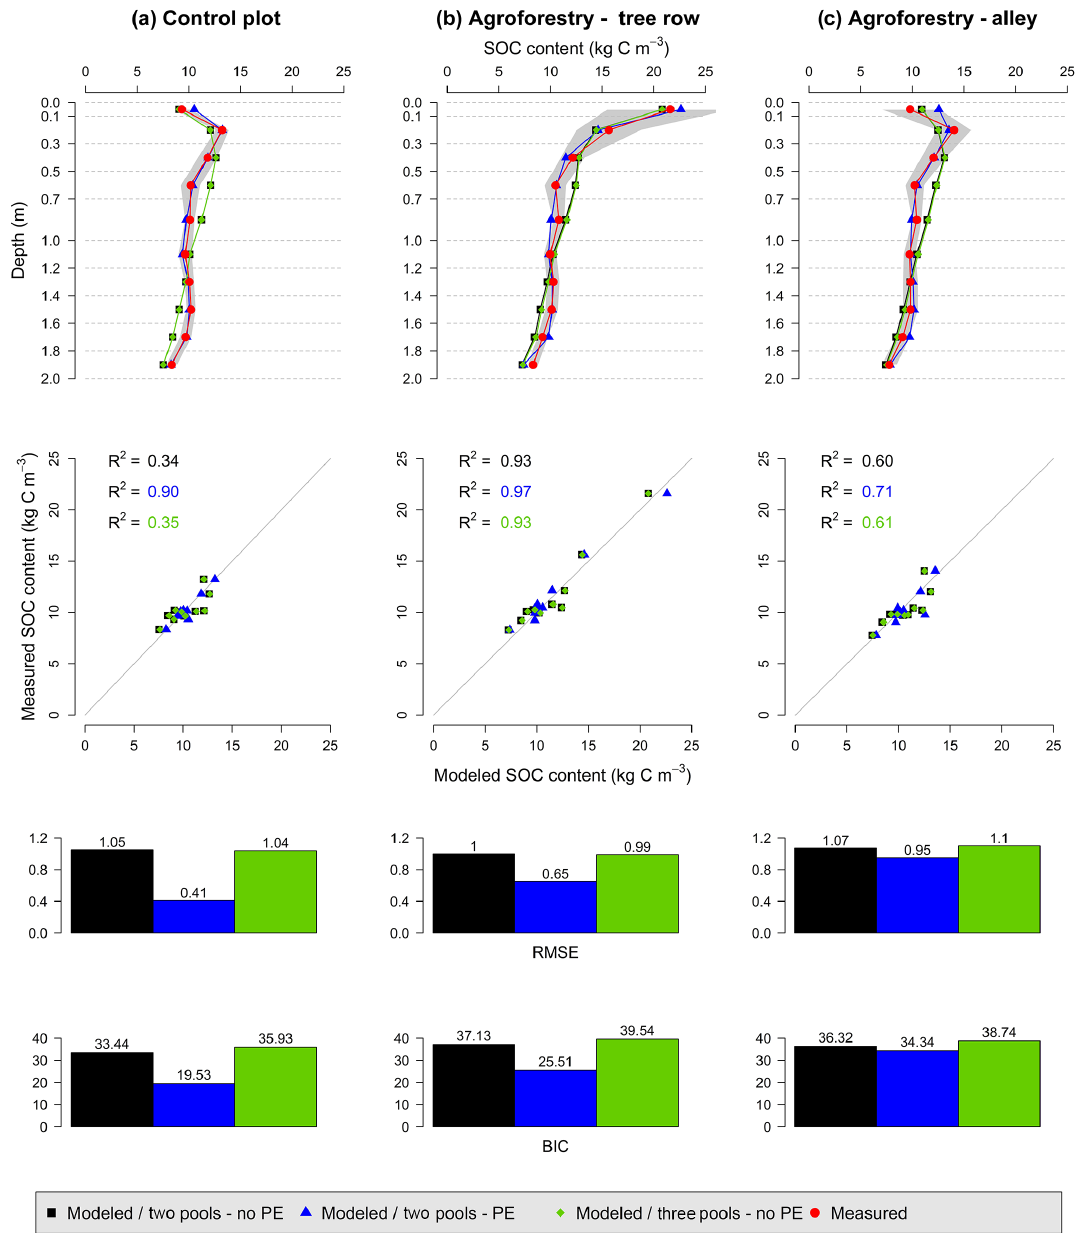
Figure 5. Measured and modeled soil organic carbon contents (kgCm − 3 ) in an agricultural control plot and in an 18-year-old silvoarable system with a two-pool model without the priming effect (no PE), with a two-pool model with the priming effect (PE), and with a three-pool model without PE. Gray shaded bands represent SDs of measured SOC stocks ( n = 93 in the control, n = 40 in the tree rows, and n = 60 in the